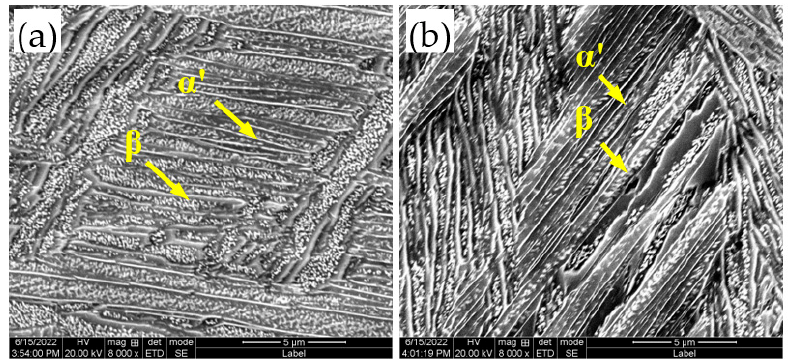
Figure 12. SEM images of laser–TIG hybrid welded joints: ( a ) arc zone; ( b ) laser zone.